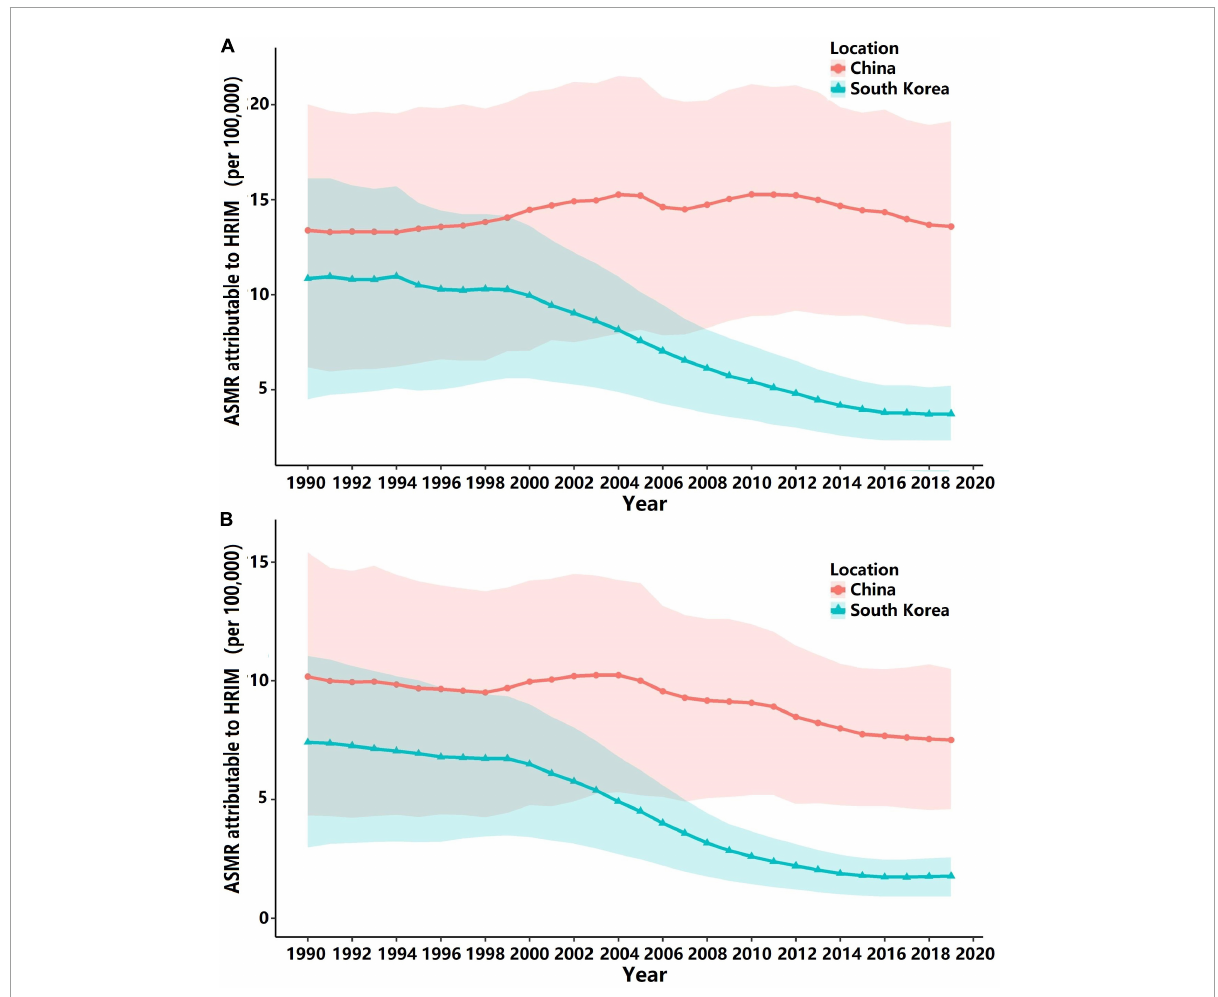
FIGURE1 Age-standardized mortality rates (ASMRs) of stroke attributable to HRMI (per 100,000) and corresponding 95% confidence intervals (presented with shadows) for both genders in China and South Korea. (A) For male individuals in China and South Korea; (B) for female individuals in China and South